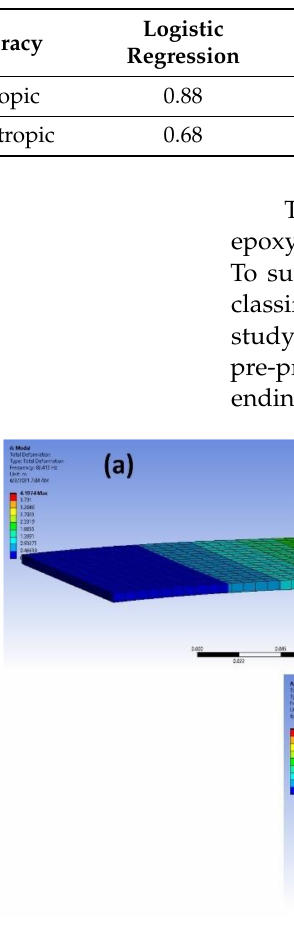
Figure 11. ( a – c ) 3 different mode shapes of epoxy carbon woven (230 GPa) wet after data